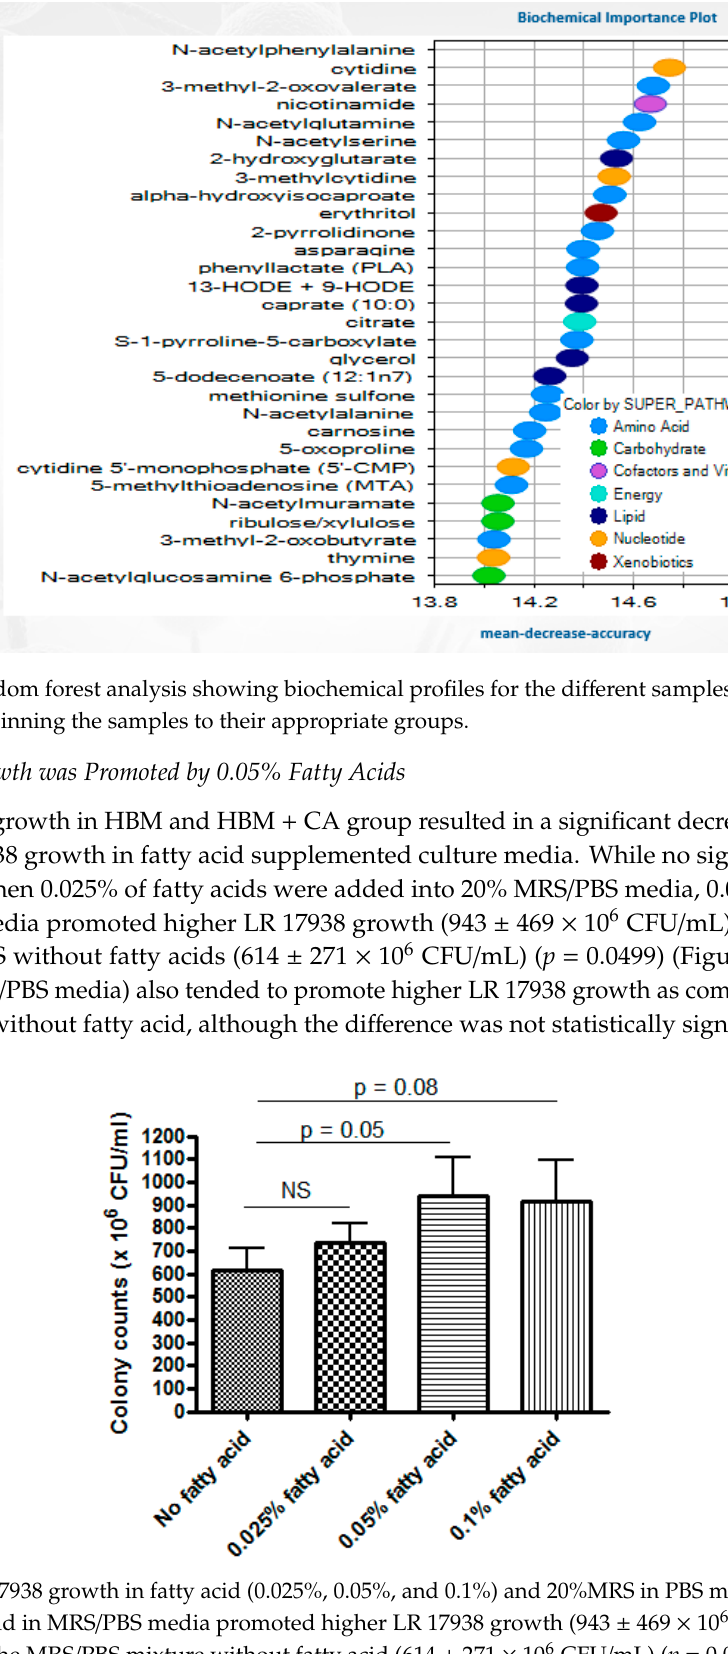
Figure 5. LR 17938 growth in fatty acid (0.025%, 0.05%, and 0.1%) and 20%MRS in PBS media. At